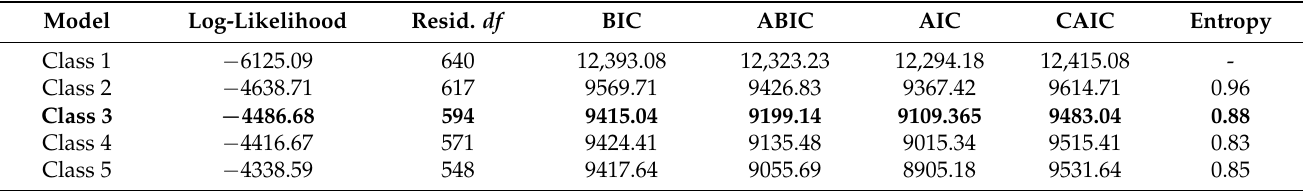
Table 4. Model fit for the optimal number of classes characterized by outpatient